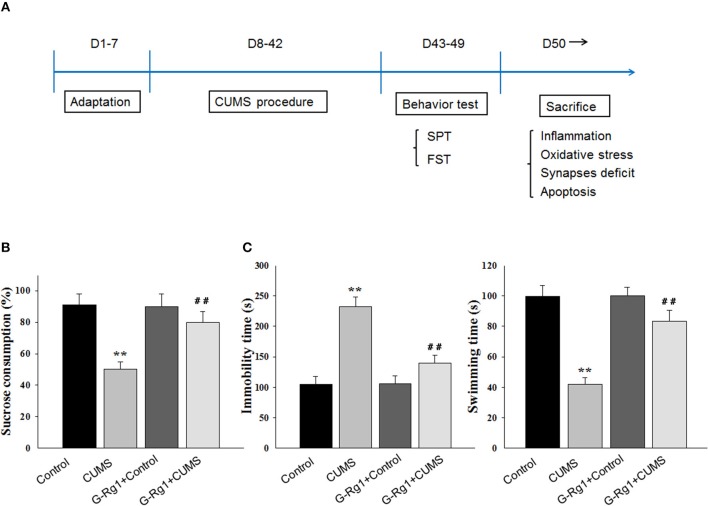
Ginsenoside-Rg1 protects against depression-like behaviors induced by CUMS exposure. (A) Experimental design: schematic figure of the treatment protocol. (B) Pretreatment of ginsenoside-Rg1 (40 mg/kg) reversed the decreased consumption of sucrose solution in CUMS-exposed rats in the sucrose preference test. (C) Pretreatment of ginsenoside-Rg1 (40 mg/kg) reversed the increased immobility times and decreased swimming times of CUMS-exposed rats in the forced swim test. All values are presented as means ± SEM (N = 18). **P < 0.01 CUMS vs. Control group; ##P < 0.01 G-Rg1+CUMS vs. CUMS group. G-Rg1, Ginsenoside-Rg1; SPT, Sucrose preference test; FST, Forced swim test.